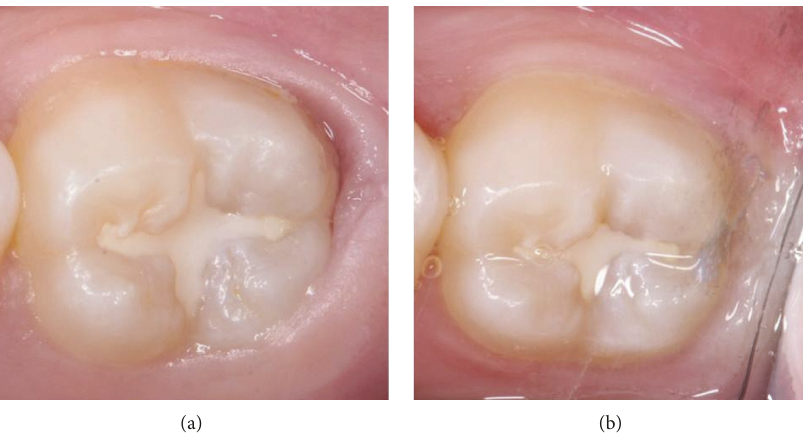
Figure 4: Occlusal appearance of the PEIR-affected tooth (permanent mandibular left second molar) (a) after sealant placement when the patient was 12 years, 5 months old and (b) at a follow-up visit when the patient was 14 years, 9 months old.